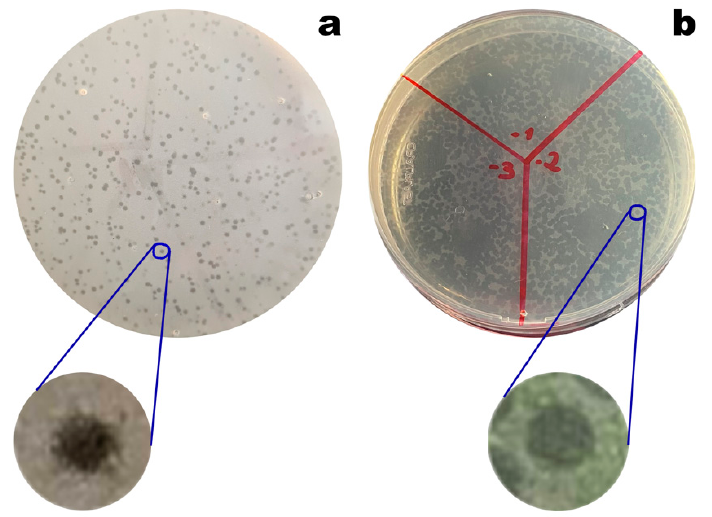
Figure 7. Morphology of phages vB_EcoM_Uniso11 ( a ) and vB_EcoM_Uniso21 ( b ) plaques on their bacterial host ( E. coli CCCD-E003). Lysis plaques are zoomed out, to observe the absence of secondary halos.